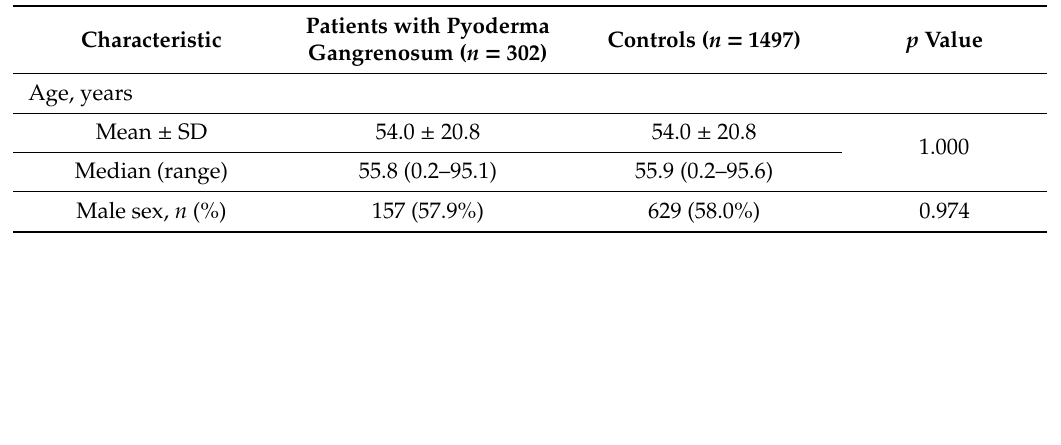
Table 1. Descriptive characteristics of the study